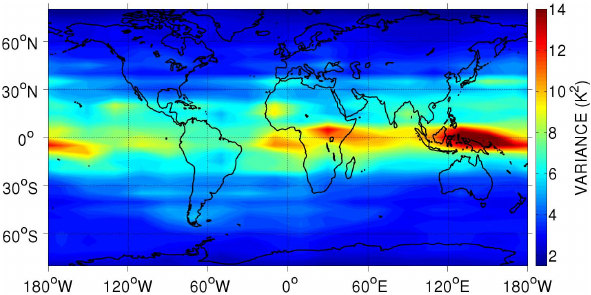
Fig. 11. Variance of temperature perturbations derived from band- passed temperature time series between periods of 2.5–4.5 days as a function of latitude and longitude from Aura MLS temperatures for 2005–2010 at a height of 97km. The sectors are of 20 ◦ longitudinal width and 10 ◦ latitudinal